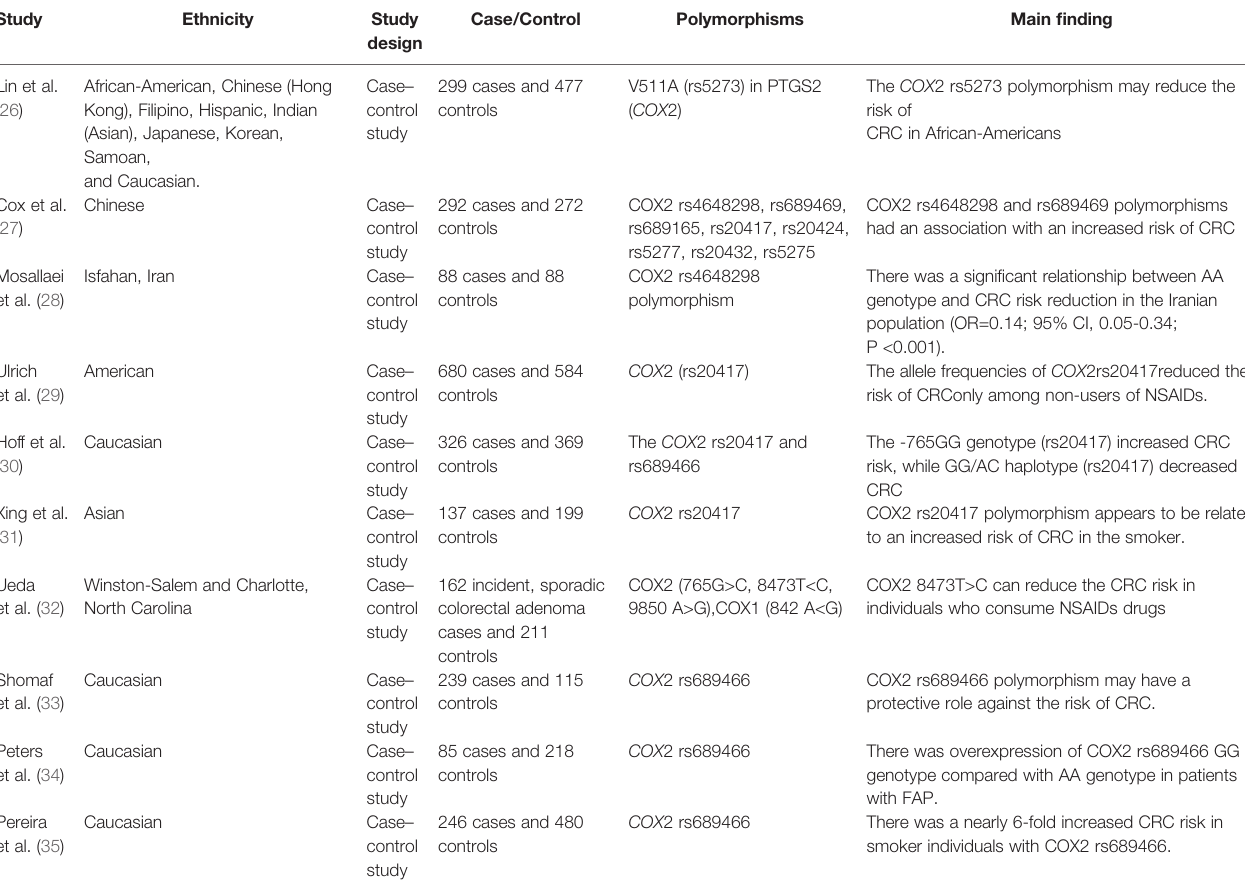
TABLE 2 | Summary of the studies related to COX gene polymorphisms and CRC